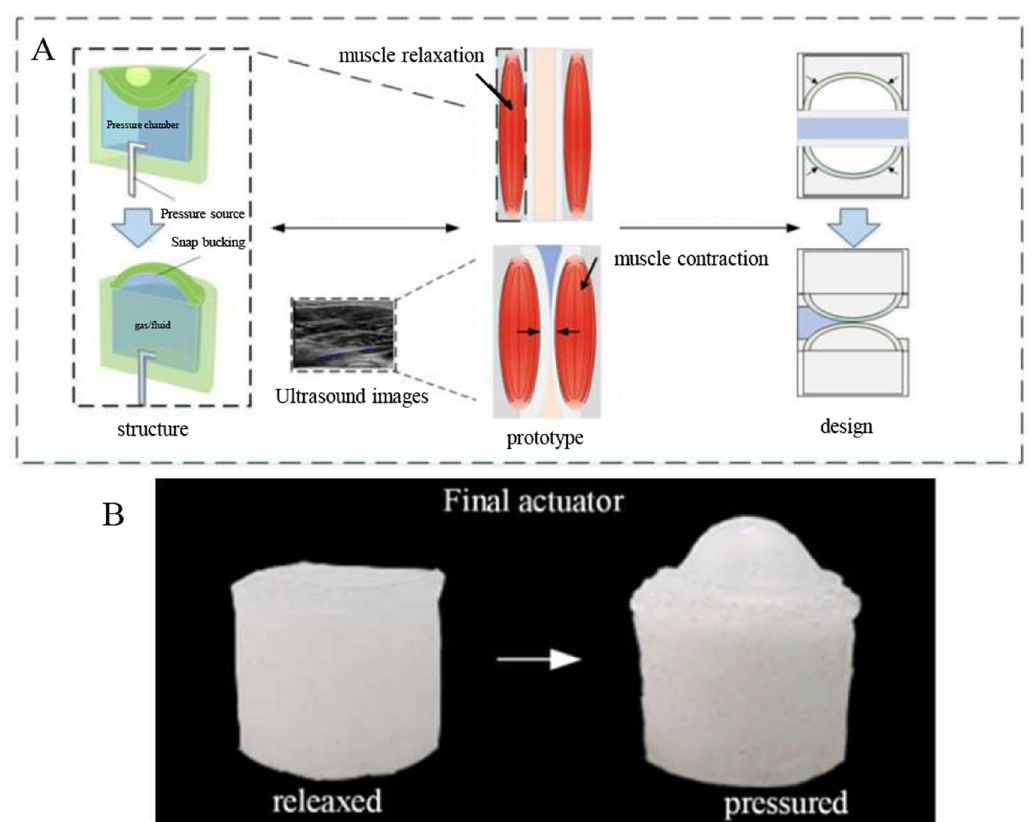
Figure 1. ( A ) Structure schematic of the new bionic flexible valve, ( B ) Physical drawing of the new bionic flexible valve.